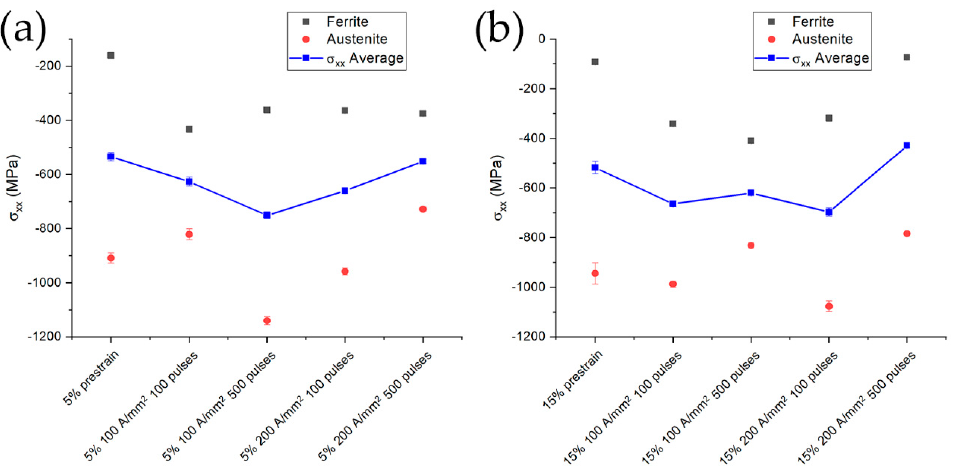
Figure 16. Evolution of transverse residual stresses in austenite (red circles), ferrite (black squares) and their average (blue thick line) for specimens prestrained and electropulsed at ( a ) 5% and ( b ) 15%.